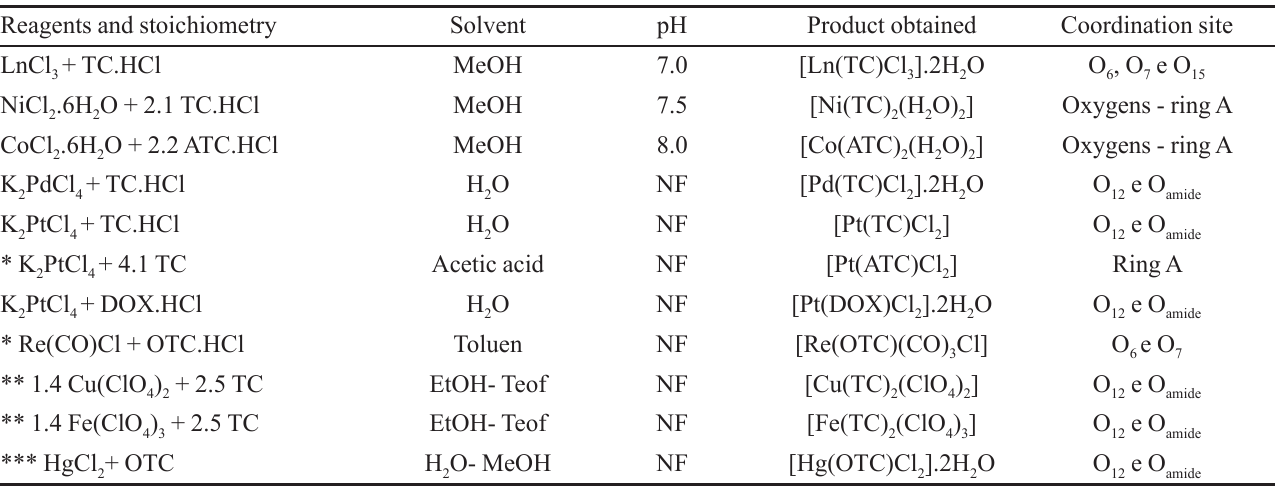
TABLE II - Metal complexes as binders using tetracycline (Pereira-Maia et al. , 2010)